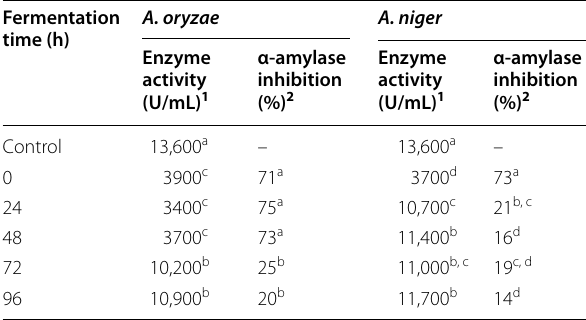
Table 3 Antidiabetic properties in terms of the α-amylase inhibition (%) of the lentil extracts obtained after 0 (nonfermented sample), 24, 48, 72 and 96 h of solid-state fermentation with A. oryzae LBA01 and A. niger LBA02